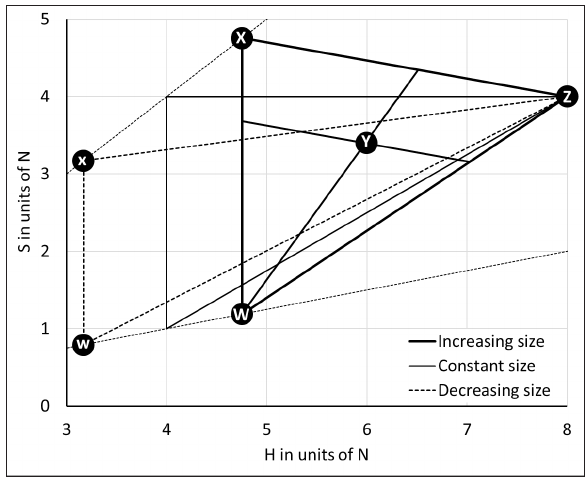
Admissible regions for H (headcounts) and S (successful credits) in the H-S plane for student throughput systems increasing or decreasing in size, as well as constant size